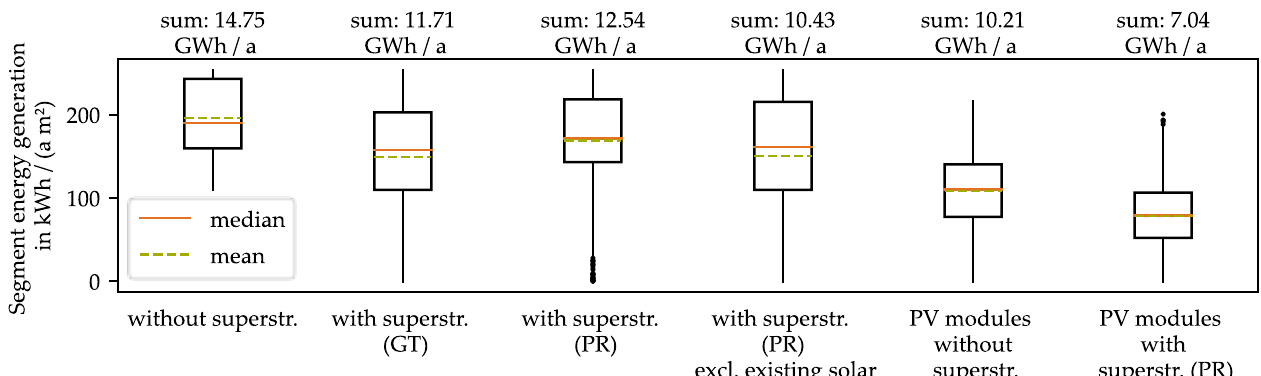
Figure 10. Boxplots of specific yearly energy generation of each roof segment in the study area for six configurations. Configuration two used ground truth (GT) superstructures and configurations three, four, and six used predicted (PR) superstructures.